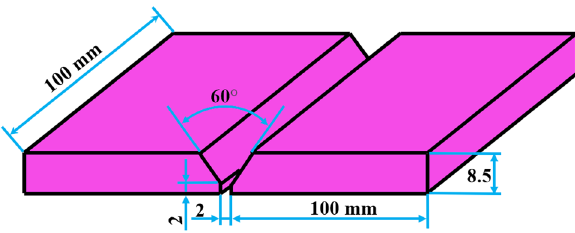
Figure 1. Schematic diagram of the V-groove